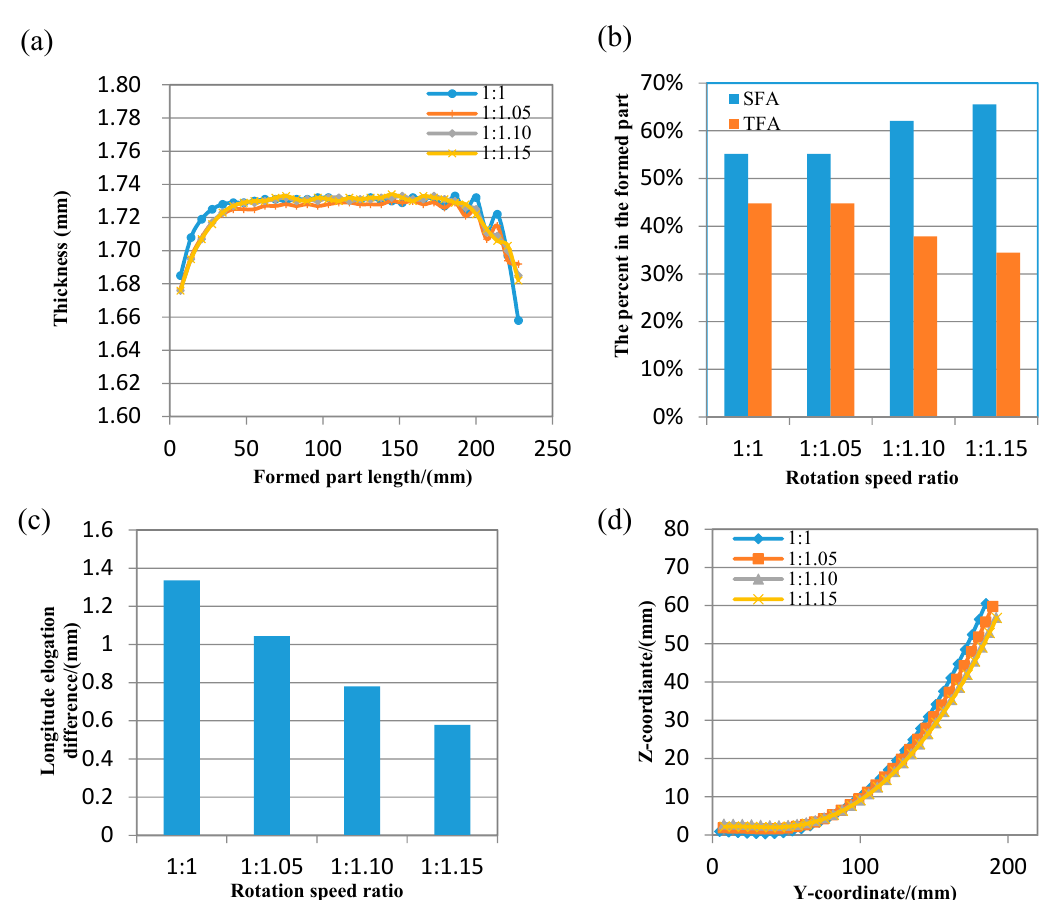
Figure 6. The formed part with different rotation speed ratio ( a ) thickness distribution ( b ) the percent of effective area ( c ) longitude elongation difference between two surfaces ( d ) longitude bending deformation.